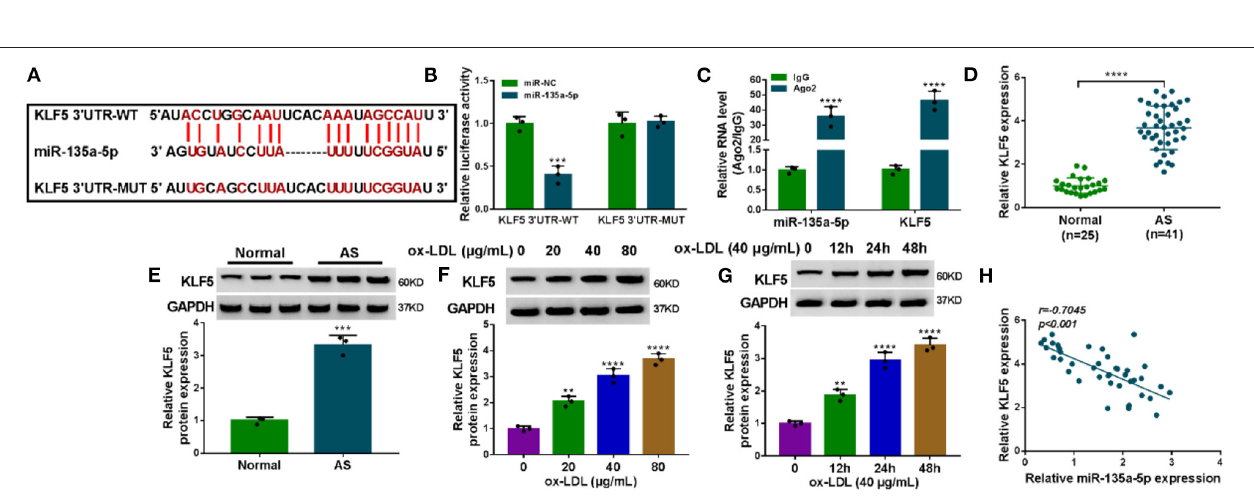
FIGURE 5 | KLF5 was a direct target of miR-135a-5p in HUVECs. (A) Schematic of the target sequence for miR-135a-5p within KLF5 3 ′ UTR and mutated miR-135a-5p-binding sites. (B) Relative luciferase activity in HUVECs cotransfected with KLF5 3 ′ UTR-WT or KLF5 3 ′ UTR-MUT and miR-NC mimic or miR-135a-5p mimic. n = 3 independent biological replicates; error bars represented SD; *** P < 0.001 by Student’s t -test. (C) The enrichments of miR-135a-5p and KLF5 by qRT-PCR in cell lysates incubated with anti-Ago2 or anti-IgG antibody. n = 3 independent biological replicates; error bars represented SD; **** P < 0.0001 by Student’s t -test. KLF5 level by qRT-PCR or western blot in atherosclerosis serum samples and normal controls (D,E) , HUVECs after stimulation with 20, 40, and 80 µ g/ml of ox-LDL for 24h (F) , HUVECs after 40 µ g/ml of ox-LDL treatment for 12, 24, and 48h (G) . Error bars represented SD; ** P < 0.01, *** P < 0.001, or **** P < 0.0001 by Student’s t -test or one-way ANOVA with Tukey’s post hoc test. (H) Correlation between KLF5 expression and miR-135a-5p level in AS serum samples using the Spearman test.